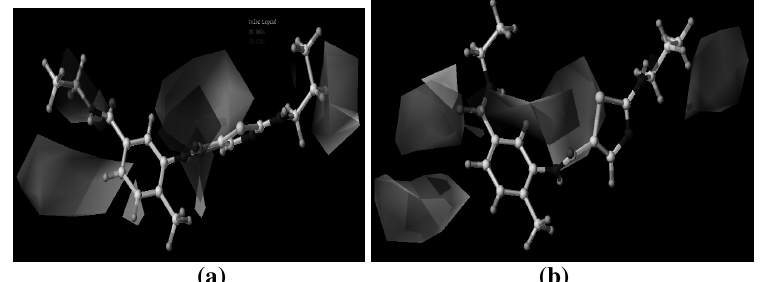
Figure 7. CoMSIA S.D. * coefficient contour maps illustrating steric, electrostatic features in combination with compound 2g. a) Ligand base and (b) Receptor base. The green contour indicates a sterically favored region; yellow maps calls for a reduction of this potential to improve activity. Blue indicates a positive charge preferred region to improve activity; Red indicates a negative charge preferred region to improve